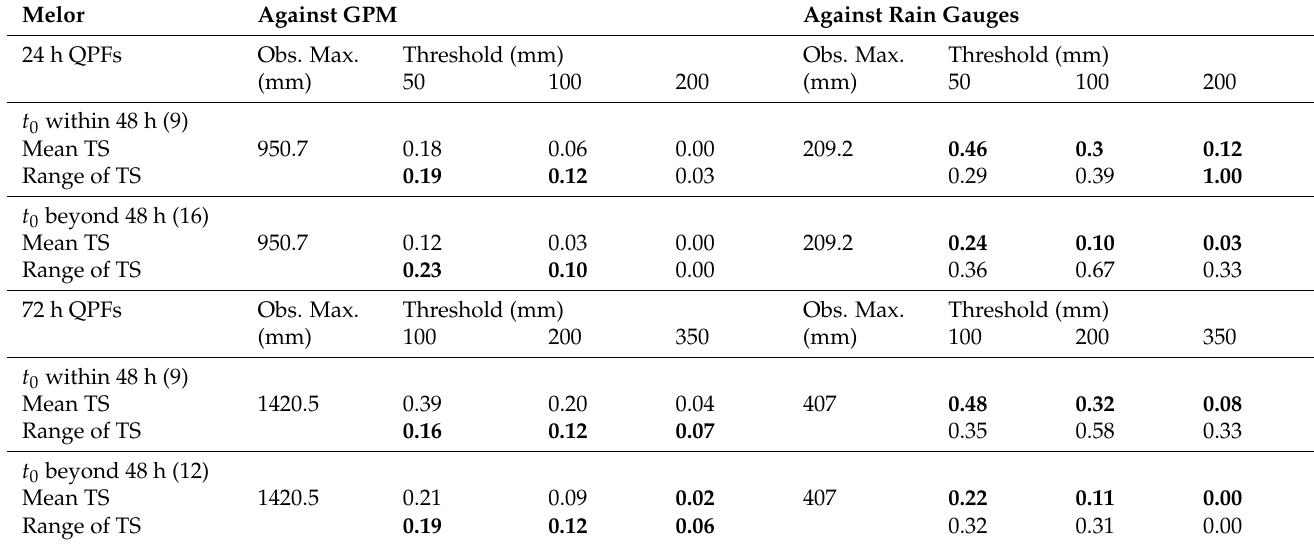
Table 4. As in Table 2, but for the comparison of TY Melor (2015), in which the 24 h QPFs are for 15 December and 72 h QPFs for 14–16 December 2015 (all in